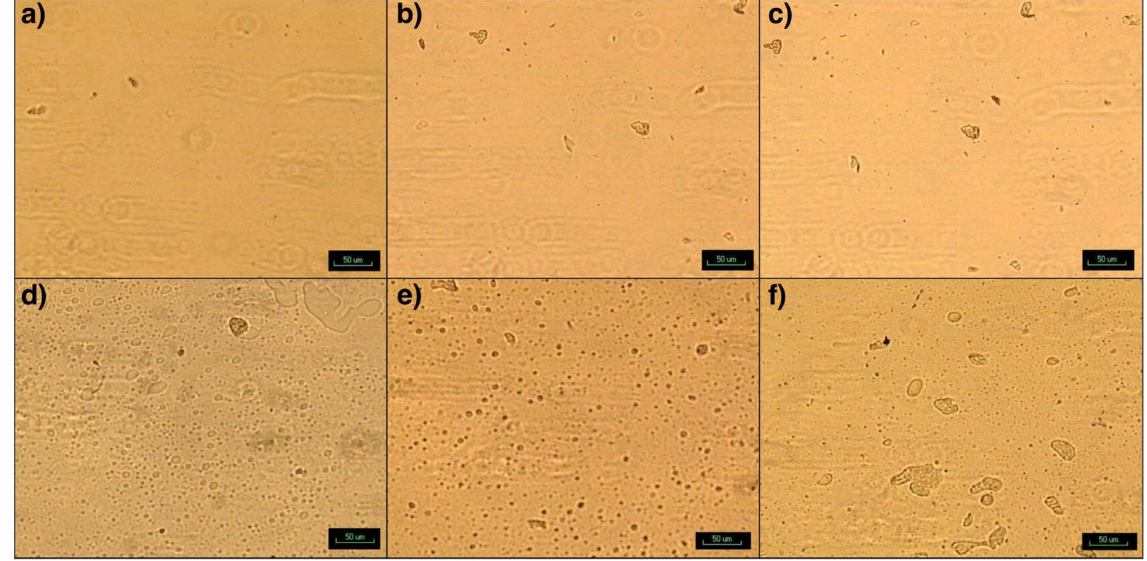
Figure 10. Photomicrographs of spherulitic structure of ( a ) C30B-CPLA, ( b )